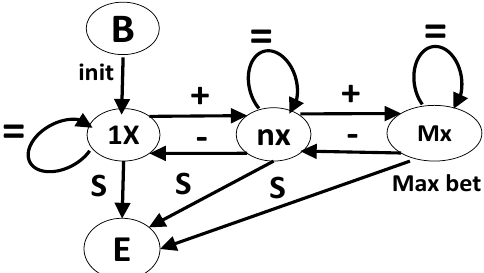
Figure 27. Automaton describing the available transitions of the slot machine The model uses finite-state automata with multiplicities composed of a set of internal states characterizing the mental situation of the player and transitions from one state to another (see Figures 25 and 26). The Figure 27 describes the automaton of the slot machine and its different states and transitions. In the following, the events k are evaluated by the score in the interval [ − 1,1] by a function E in Equation (12). Each transition is associated with a probability that indicates